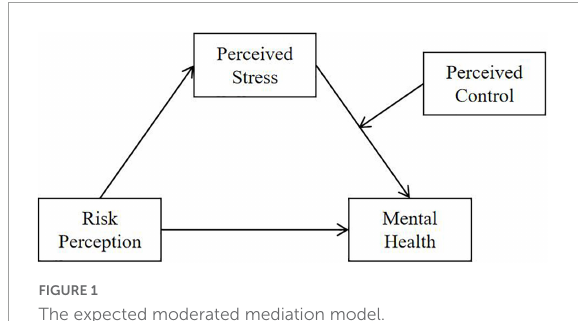
FIGURE1 The expected moderated mediation